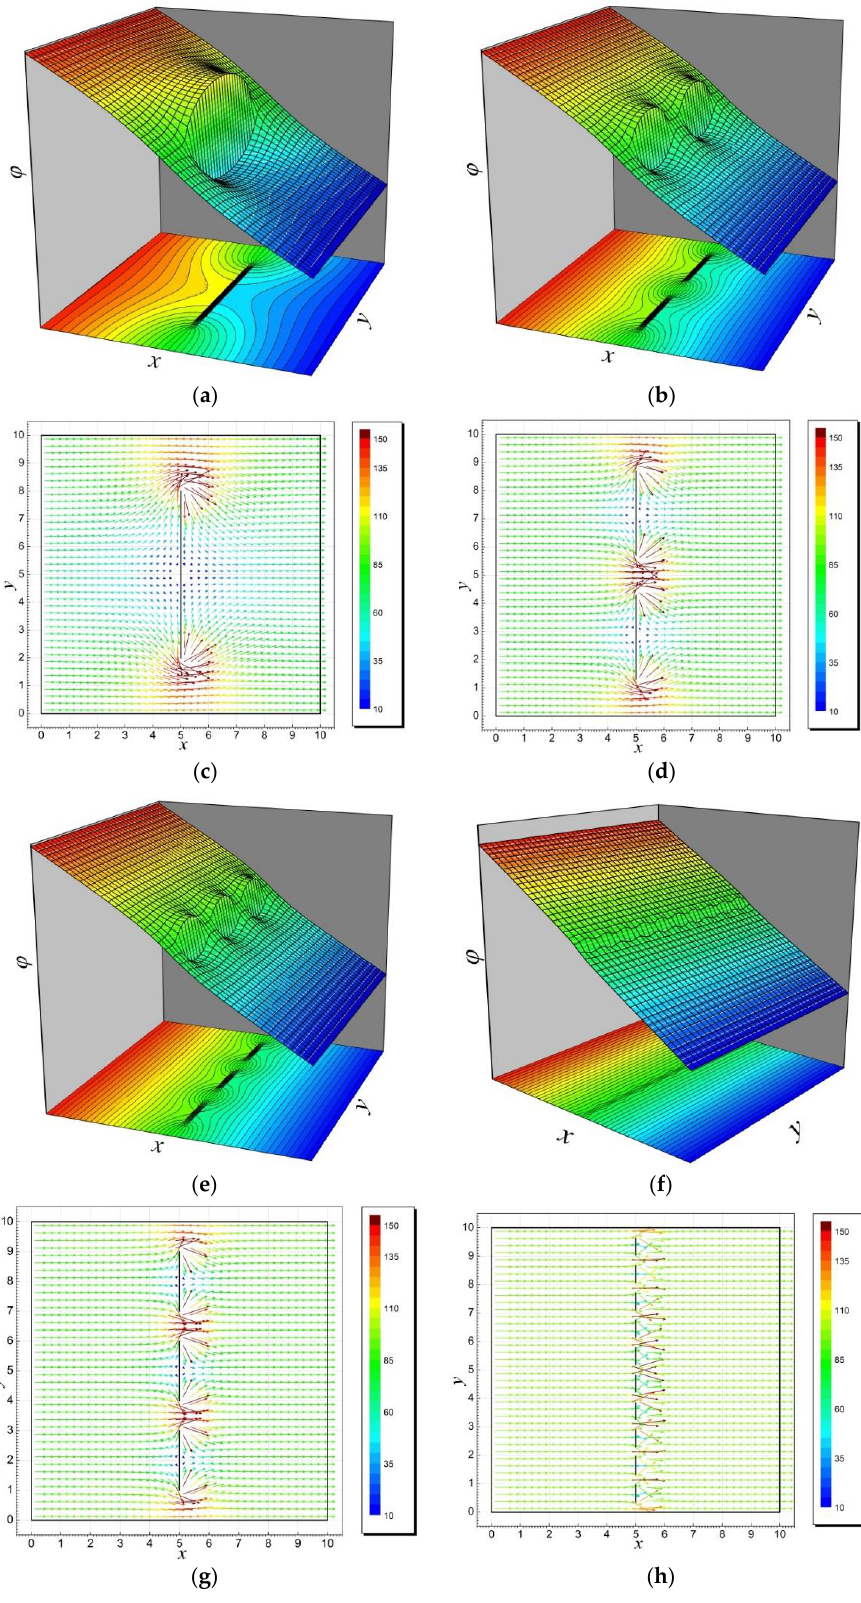
Figure 3. Results of simulation of potential ( a , b , e , f ) and current density vectors ( c , d , g , h ) for one ( a , c ), two ( b , d ), three ( e , g ), and ten ( f , h ) collinear defects with a total length d s = 60% of the whole stripe width; arbitrary units.